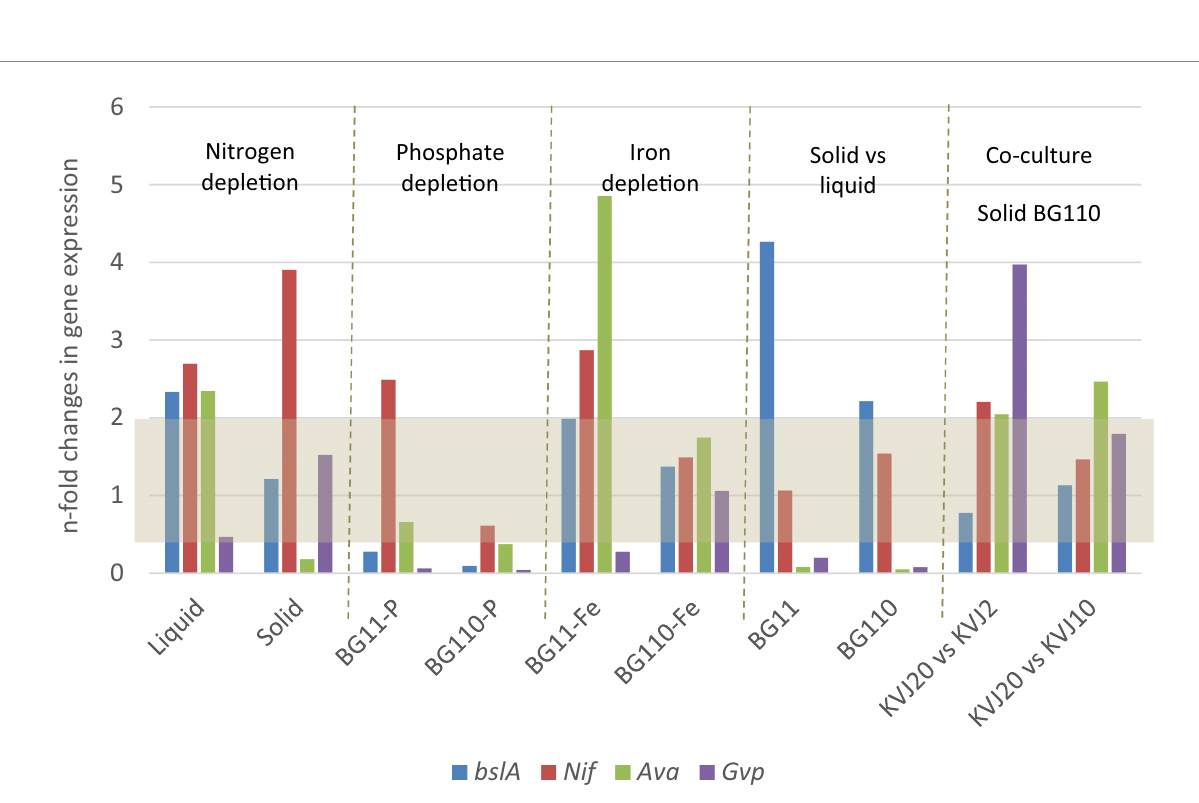
FIGURE 6 Results of the gene expression studies. The results are given as gene expression n-fold change in Nostoc sp. KVJ20 for the NRPS gene bslA , marker for nitrogen fixation nitrogenase ( nifH ), akinete formation marker ( avaK ), and hormogonia differentiation marker ( gvpC ). The fold changes were calculated as follows. For nitrogen depletion liquid cultures in BG110 medium were compared to liquid cultures in BG11 medium; similarly, the cultures on solid BG110 were compared to cultures on solid BG11. For iron and phosphate depletions, as well as solid vs. liquid grown, the nitrogen regime was the same in mutually compared cultures. The gene expression in colonies grown aside another strain (co-culture) on BG110 agar were compared to cultures on solid BG110 medium with another Nostoc sp. KVJ10 or KVJ2 colony as neighbor (Liaimer et al., 2016). The gray area covers the values with less than two-fold change in expression.